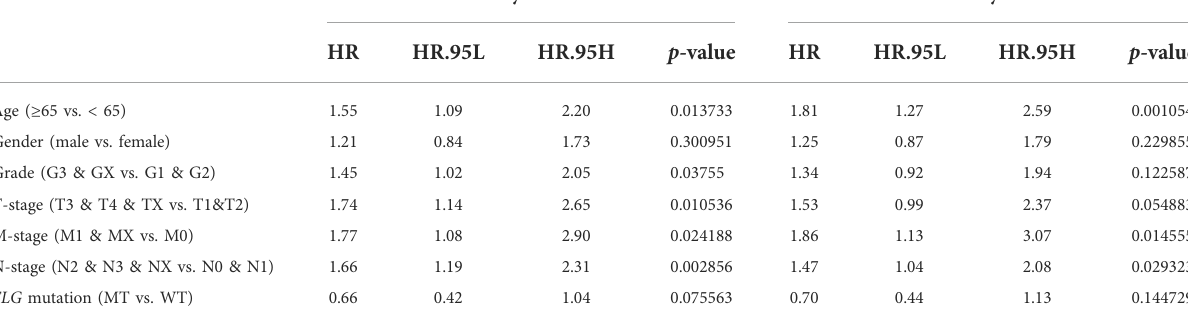
TABLE 2 Univariate and multivariate analyses with the Cox proportional hazards regression model based on FLG gene mutation for predicting OS in TCGA database.